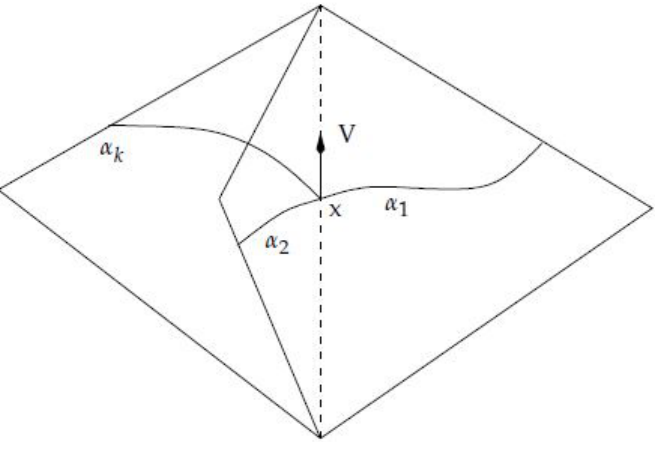
Figure A4. Curvature at an intersection point with an